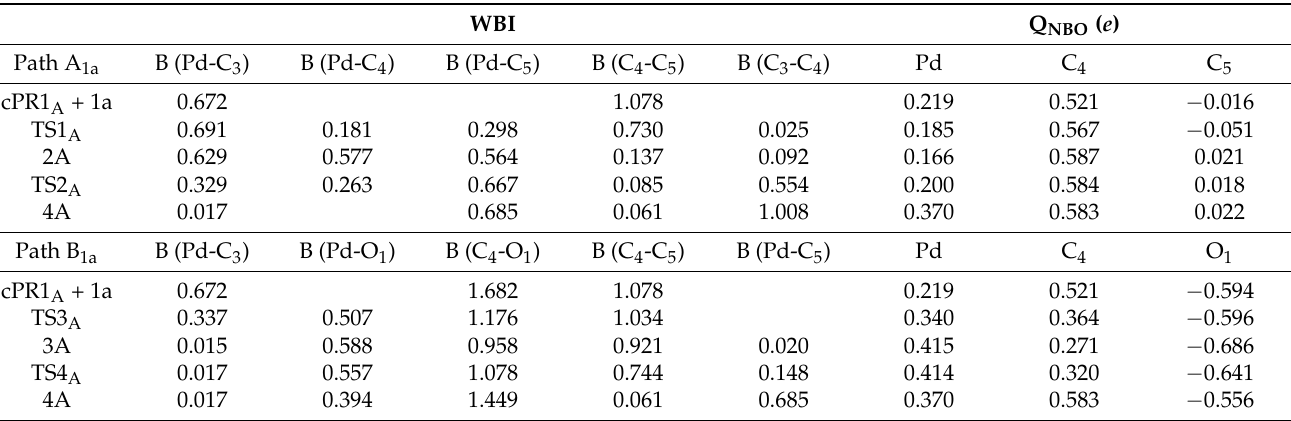
Table 2. The Wiberg bond indices (WBIs) and natural charges (Q NBO ) for some key bonds and atoms of the reaction pathway for cyclopropenone. WBI Q NBO ( e